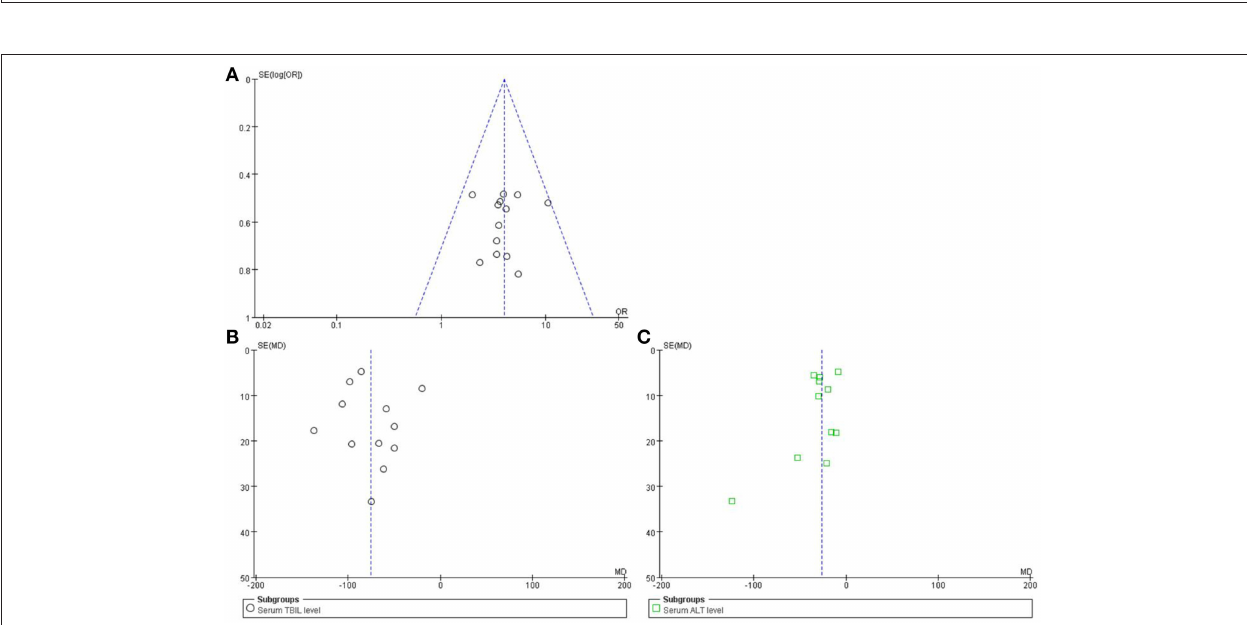
FIGURE 10 | Funnel plot of high-dose PRR-relevant formulae. (A) The plot of efficacy rate, (B) serum index of TBIL, and (C) serum index of ALT was symmetric, suggesting that the publication bias was small.